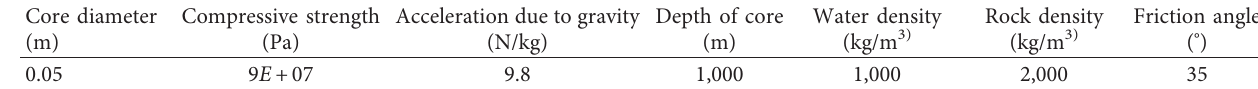
Table 1: The core parameters for calculation.